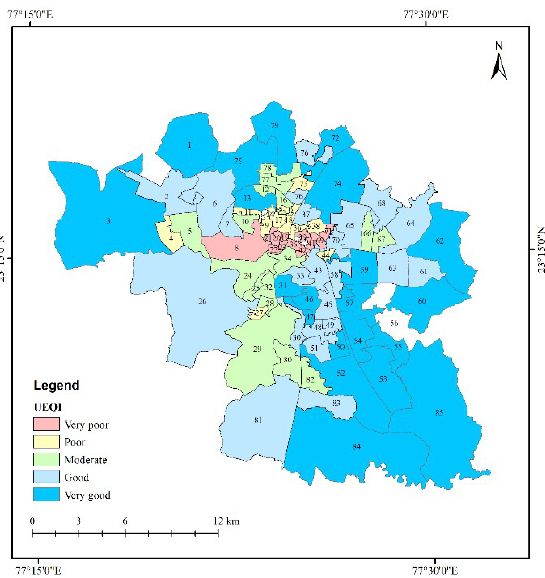
Figure 10. Map of ward-wise urban environmental quality of